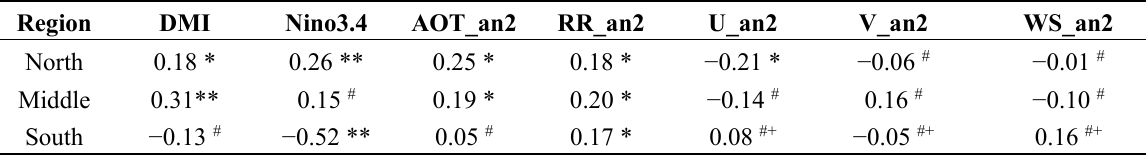
Table 1. Correlation coefficients ( r -values) associated with linear regressions of chlorophyll- a concentration anomaly (Chl- a _an2) on DMI (second column), Nino3.4 (third column), aerosol optical thickness anomaly (AOT_an2, fourth column), rain rate anomaly (RR_an2, fifth column), zonal wind anomaly (U_an2, sixth column), meridional wind anomaly (V_an2, seventh column) and wind speed anomaly (WS_an2, eighth column) in the northern, middle and southern regions of the SM. Because there were no wind field observations in the southern region, the r associated with regressions of SeaWiFS Chl- a _an2 on wind field anomalies in the southern region were derived by using wind field anomalies from the middle region of the SM on the assumption that characteristics of the middle region wind field were, to some degree, also representative of the southern region wind